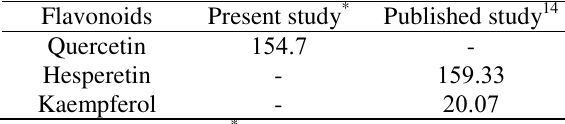
Table 3. Comparison of studied flavonoids content and published data.